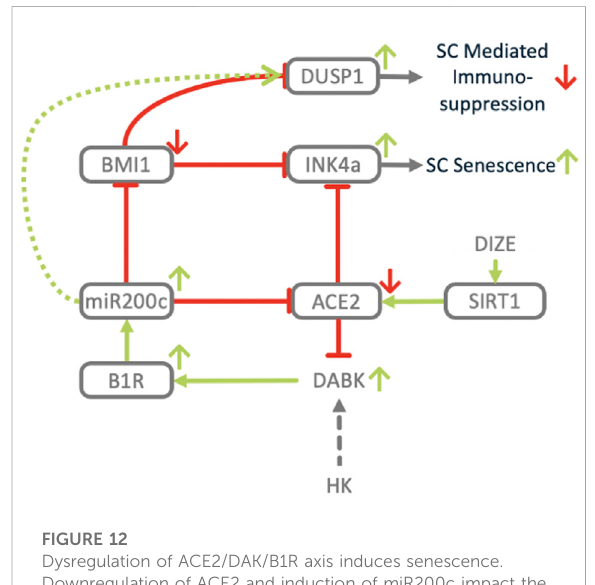
FIGURE 12 Dysregulation of ACE2/DAK/B1R axis induces senescence. Downregulation of ACE2 and induction of miR200c impact the expression of key regulators of senescence. BMI1. Inhibition of BMI1 via upregulation of p16INK4a induces stem cell senescence. Upregulation of DUSP1 has been associated with